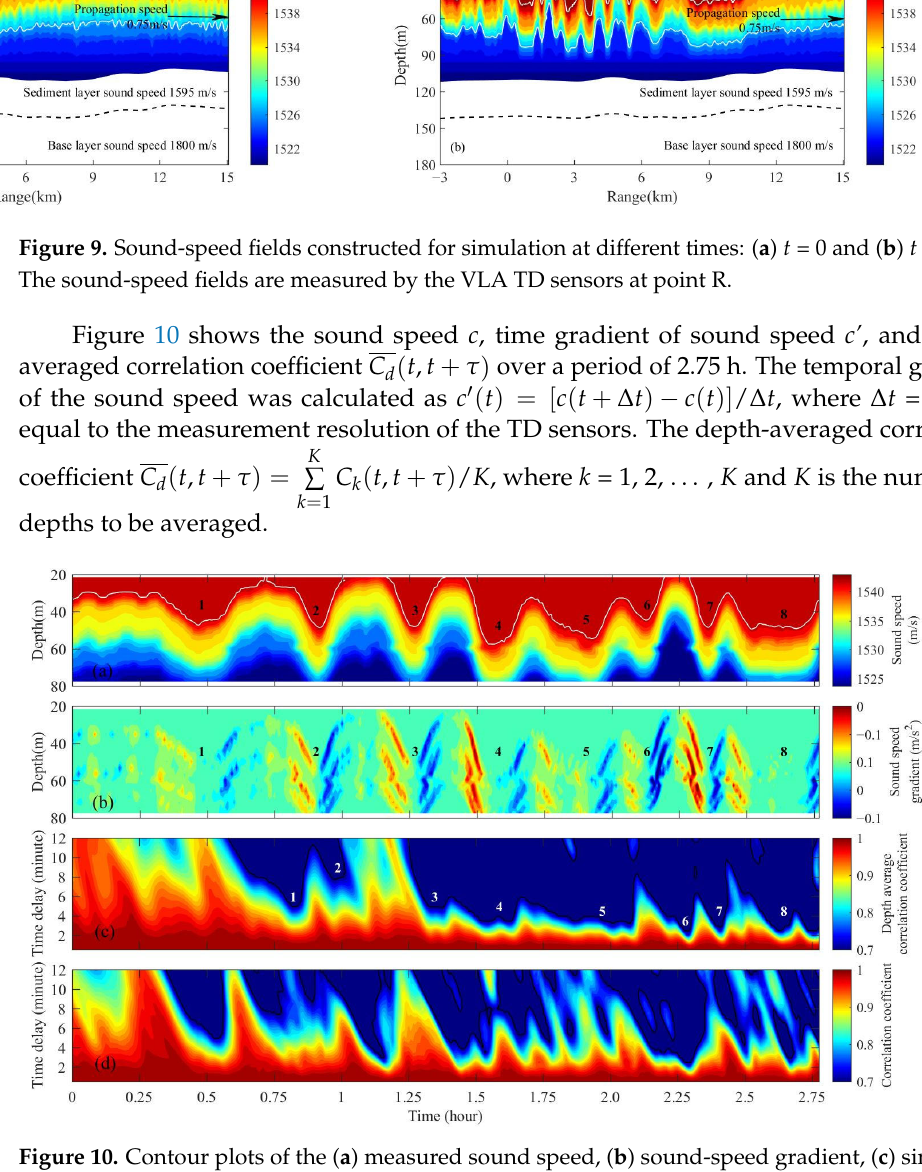
Figure 9. Sound ‐ speed fields constructed for simulation at different times: ( a ) 𝑡 = 0 and ( b ) 𝑡 = 2.75 h. The sound ‐ speed fields are measured by the VLA TD sensors at point R.